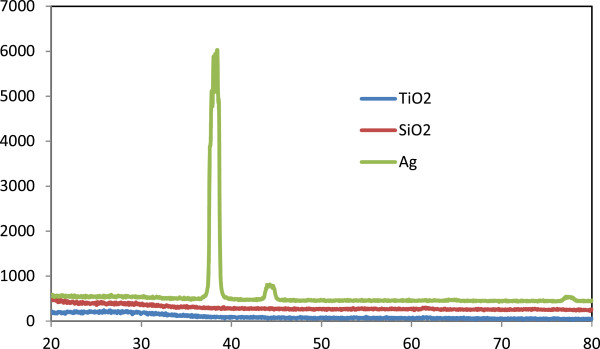
XRD patterns of TiO2 and SiO2 thin films fabricated on glass. XRD patterns showing that the TiO2 and SiO2 thin films fabricated on glass by E-beam evaporation with IAD exhibit a preferential amorphous growth.